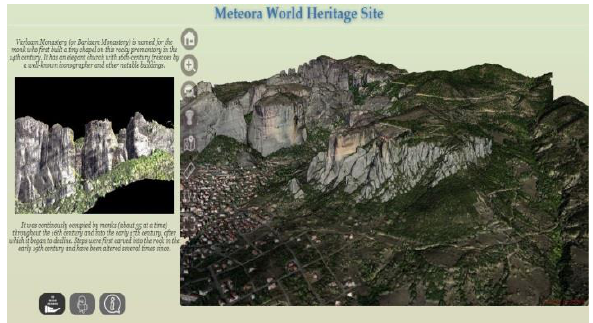
Figure 2. The framework’s main page featuring the 3D model of Three.js viewer (left of the